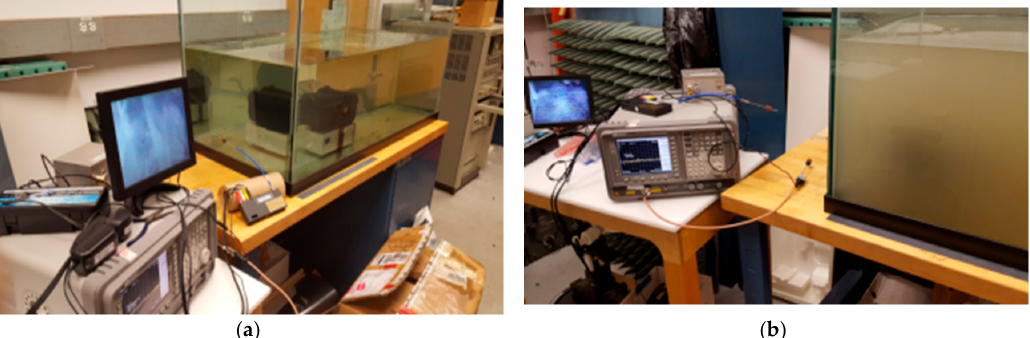
Figure 5. ( a ) Similar to experiments depicted in Figure 4, a 2.4 GHz surface wave antenna transmits video signal from inside an aquarium filled with seawater; ( b ) The video transmission is not affected by water turbidity.